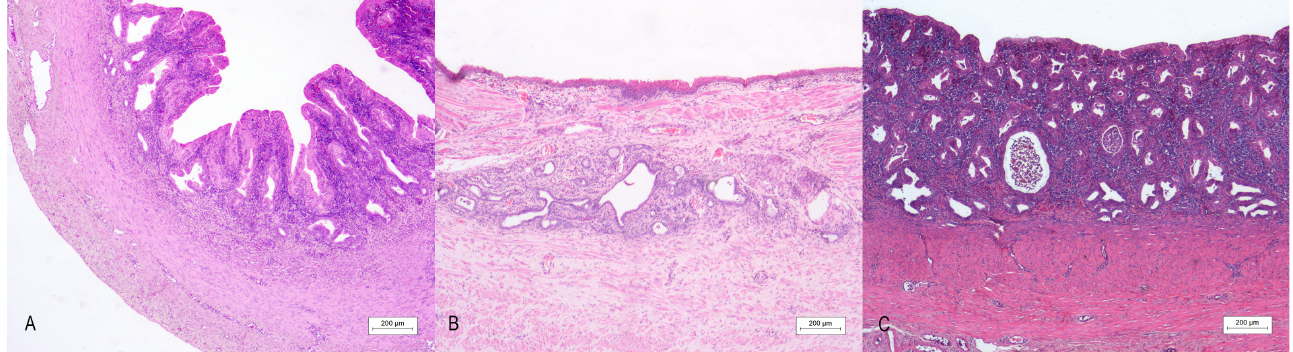
Figure 3. Uterus masculinus , histological findings: ( A ) Case number 3: The wall of the uterus masculinus with a three-layer appearance. Bar 200 µm. ( B ) Case number 2: Longitudinal section of the mucosal wall with squamous epithelium. Bar 200 µm. ( C ) Case number 1: Moderate lymphoplasmacytic and neutrophilic inflammation of the mucosal layer of the canine uterus masculinus . ( A – C ): Under 4× magnification, bar 200 µm, hematoxylin–eosin stain.